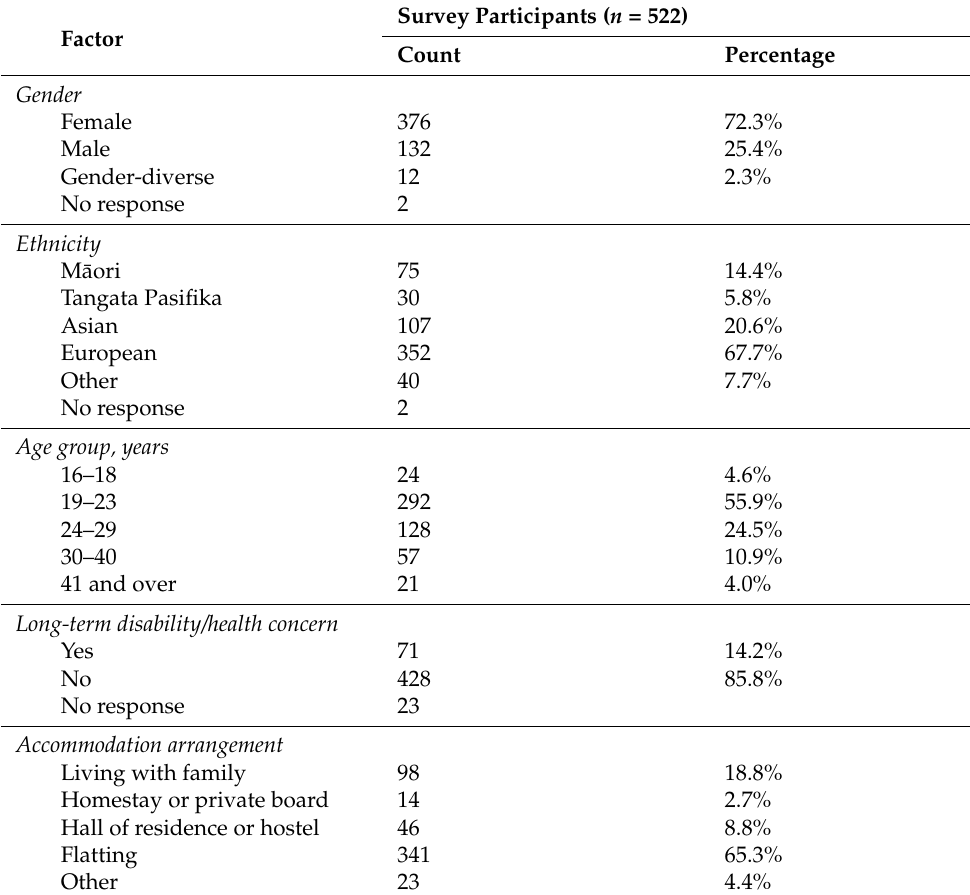
Table 1. Participant